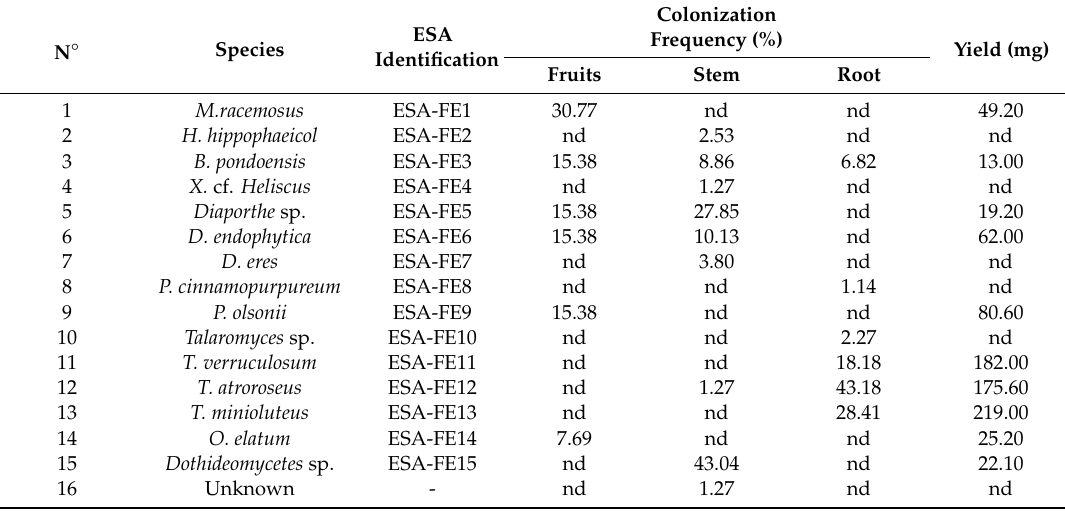
Table 2. Frequency of colonization (%) and yield of the ethyl acetate extract of endophytic fungi isolated from fruits, stem bark and roots of S. terebinthifolius .